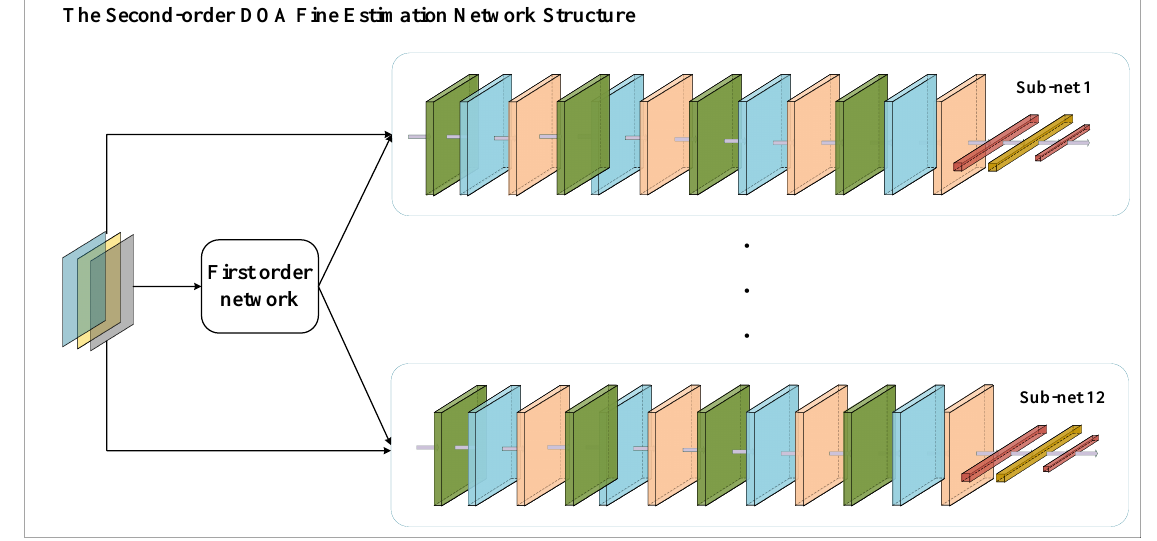
Figure 6. The second-order DOA fine estimation network structure.